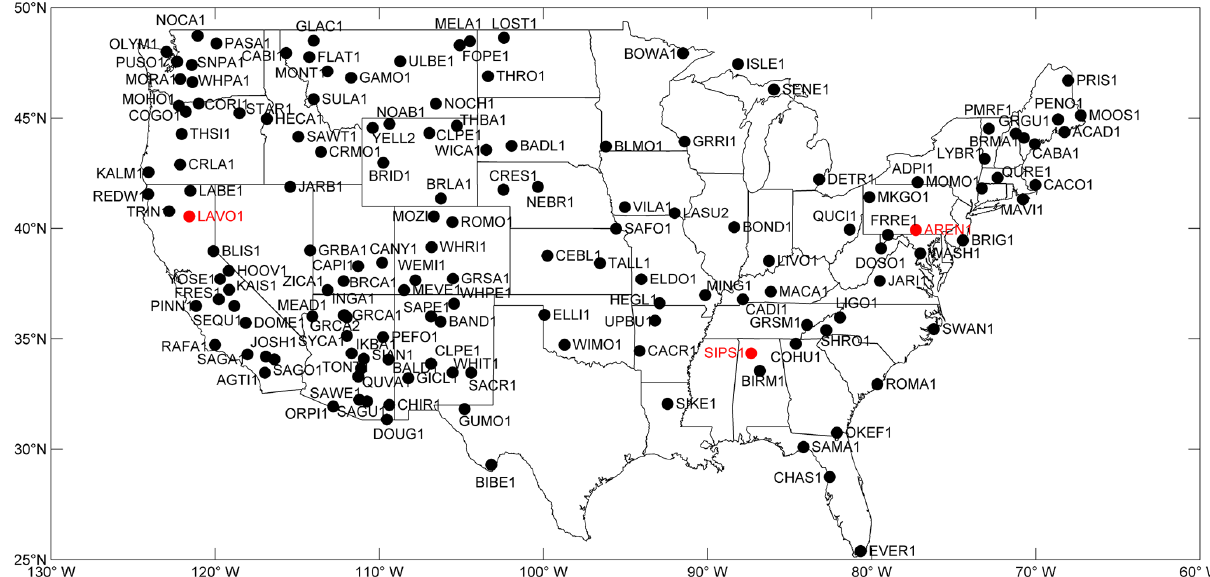
Figure 1. Geographical location of IMPROVE sites for PM 2 . 5 . Red dots are three representative